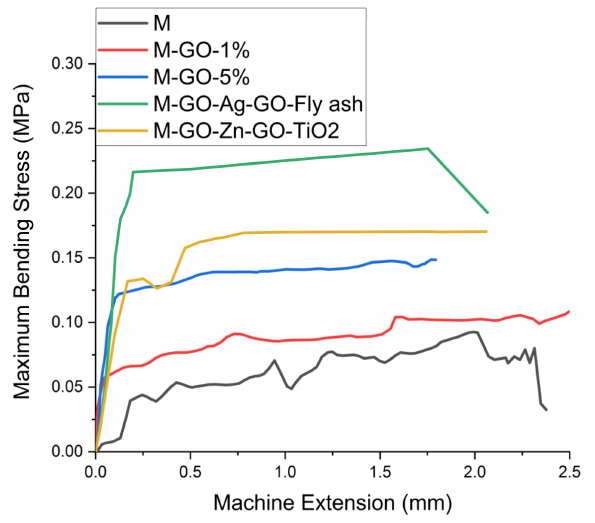
Figure 5. Push-off